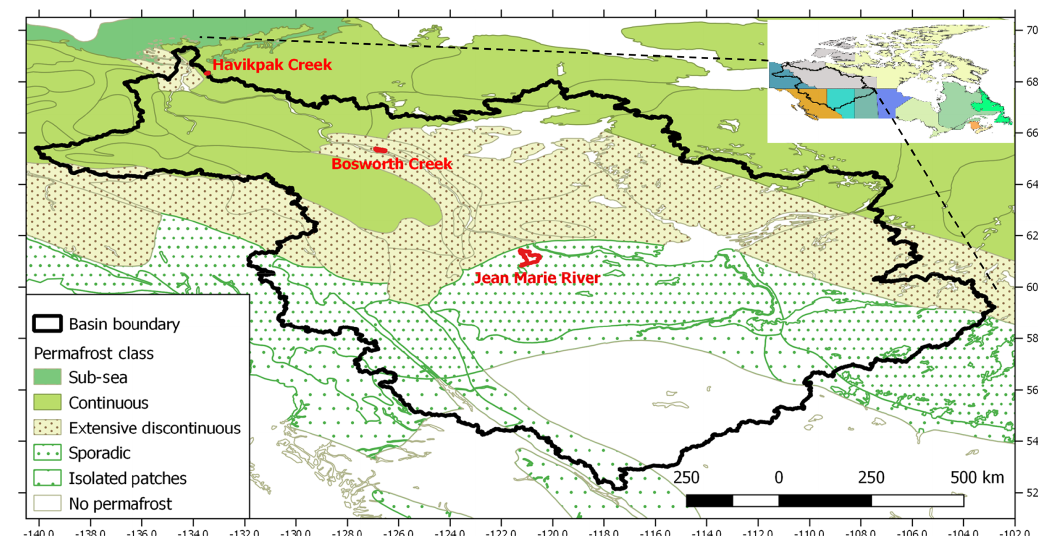
Figure 2. Mackenzie River basin: location, permafrost classification, and the three study